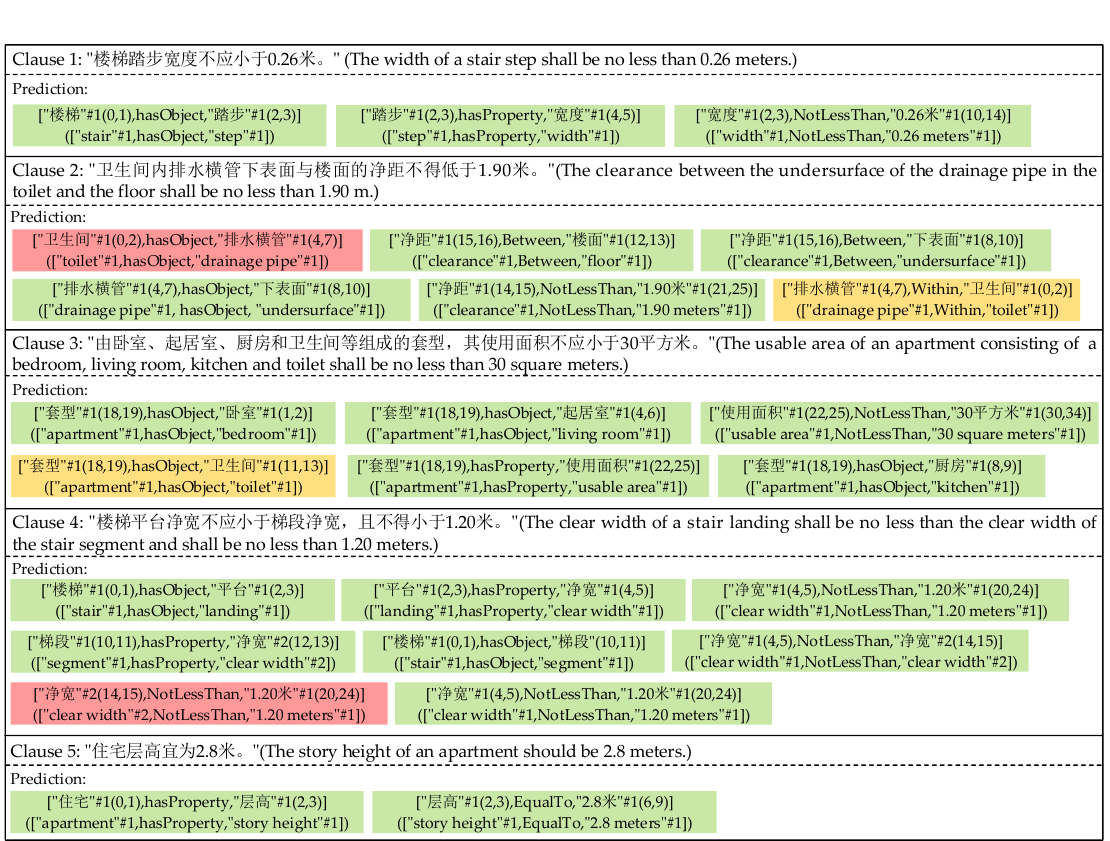
Figure 6. Results of model testing